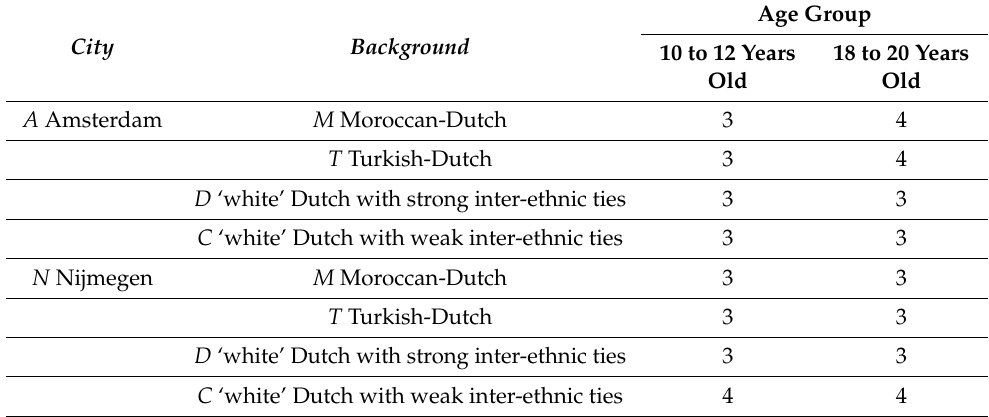
Table 2. The speaker design for the present study. Age Group City Background 10 to 12 Years 18 to 20 Years Old Old A Amsterdam M Moroccan-Dutch 3 4 T Turkish-Dutch 3 4 D ‘white’ Dutch with strong inter-ethnic ties 3 3 C ‘white’ Dutch with weak inter-ethnic ties 3 3 N Nijmegen M Moroccan-Dutch 3 3 T Turkish-Dutch 3 3 D ‘white’ Dutch with strong inter-ethnic ties 3 3 C ‘white’ Dutch with weak inter-ethnic ties